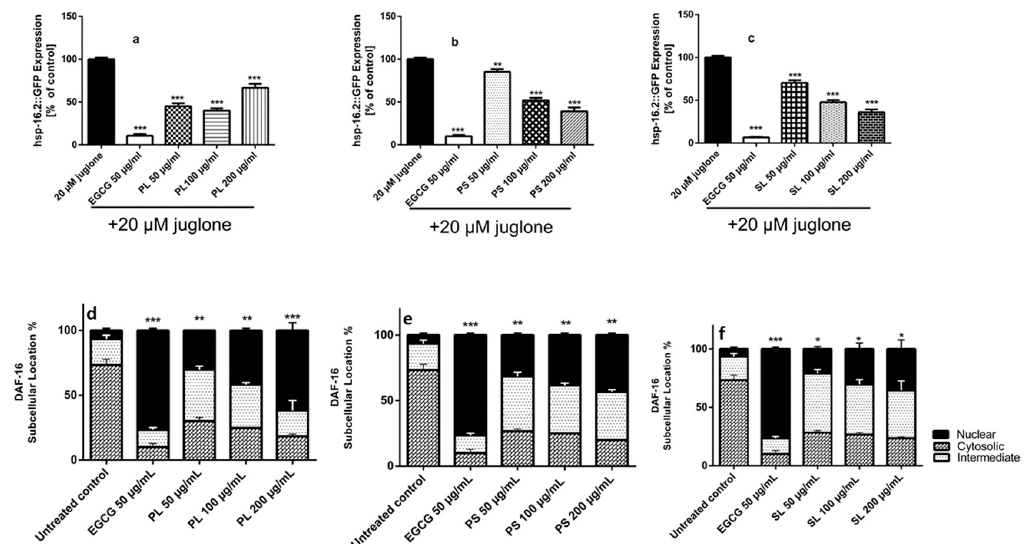
Figure 5. E ff ect of EGCG (epigallocatechin gallate) and extracts of PL ( P. alba leaf), PS ( P. alba shoots) and SL ( S. subserrata leaf) on: hsp-16.2::GFP (green fluorescence protein) expression in the mutant strains TJ375 under juglone induced oxidative stress, juglone treated control was set 100% ( a ) The hsp-16.2::GFP expression levels was significantly reduced by 54.77%, 60.06% and 33.46% after pre-treatment of the worms with 50,100 and 200 µ g / mL PL, respectively, followed by Juglone(20 µ M). ( b ) PS significantly reduced hsp-16.2::GFP expression levels to 85.24%, 51.88% and 39.08% after pre-treatment of the worms with 50,100 and 200 µ g / mL extract PS, respectively, followed by juglone(20 µ M) ( c ) The hsp-16.2::GFP expression levels was significantly reduced by 29.55%, 52.43% and 64.03% after treatment of the worms with 50,100 and 200 µ g / mL extract SL, respectively, followed by juglone (20 µ M). Nuclear localization of DAF-16::GFP in the transgenic worms TJ356: ( d ) PL induced nuclear localization with 30.27, 41.73, and 61.77% by 50, 100, and 200 µ g / mL respectively. ( e ) PS exerted subcellular nuclear translocation with 31.67, 38.33, 43.33% by 50, 100, and 200 µ g / mL respectively. ( f ) SL demonstrated weak activities and activated DAF-16 with 21.00, 30.33, 35.67% by 50, 100, and 200 µ g / mL respectively. EGCG was used a positive control. One-way ANOVA followed by Bonferroni (post –hoc) (** p < 0.01, *** p < 0.0001) was used for the analysis of statistical significance of di ff erences between non-treated control and treated groups. The results are recorded as mean ± SEM from three independent